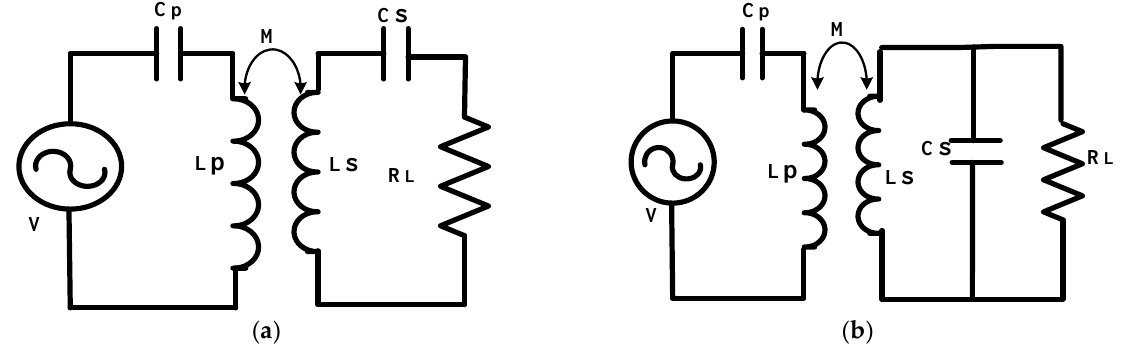
Based on application requirements, the selection of suitable compensation topology is made. The series compensation is suitable for a primary long-path side-coupled system with capacitors connected along the paths. The voltage and current requirements for Series compensation are higher than the Parallel compensation. SS compensation is more efficient for high-power applications with dynamic load characteristics, such as charging vehicles within multikilowatt loads [14]. Moreover, it is helpful in segmented dynamic WPT applications where the voltage delivered to the secondary is enormously high, with coupling coefficient fluctuations. The equivalent circuits of the SS and SP compensation topologies are shown in Figure 3 [9].